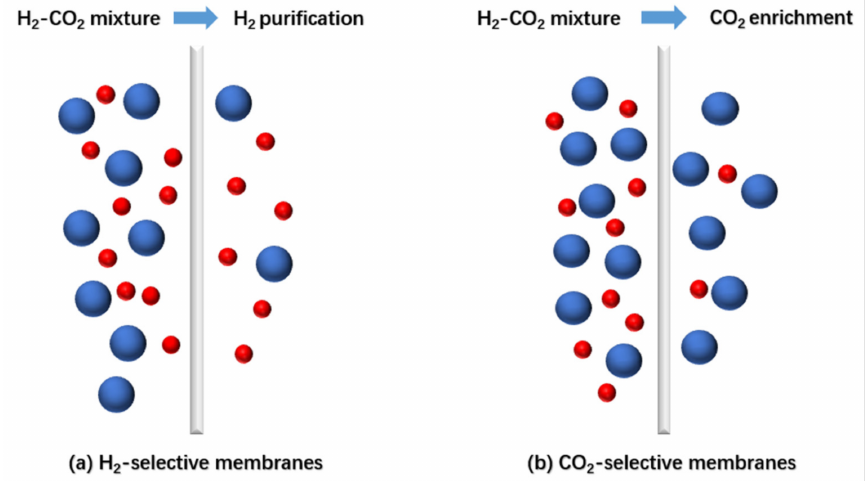
Figure 3. Schematic representation of ( a ) H 2 -selective and ( b ) CO 2 -selective